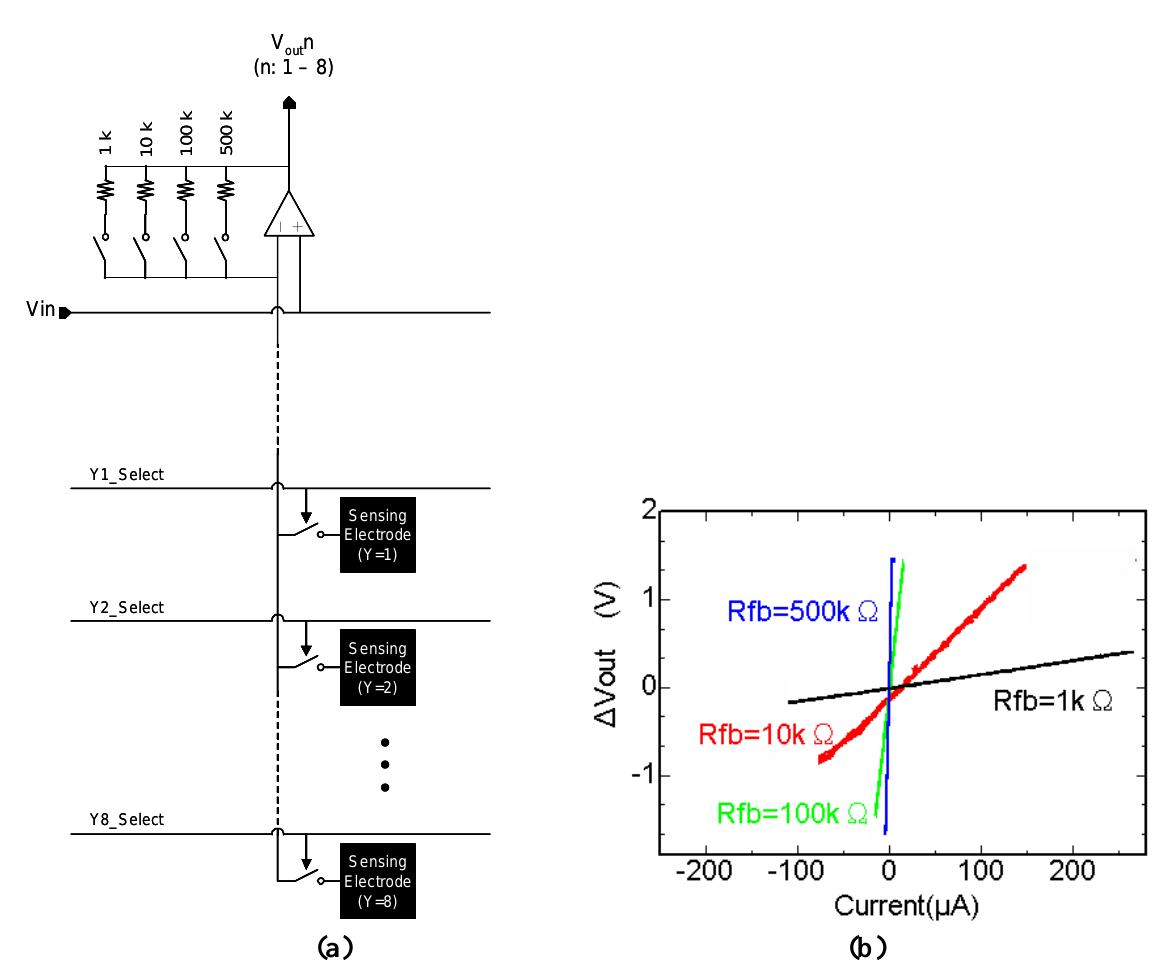
Figure 9. (a) Block diagram of the conductively coupled electric sensing pixel array and (b) measurement characteristics of the potentiometric amplifier unit (adapted from